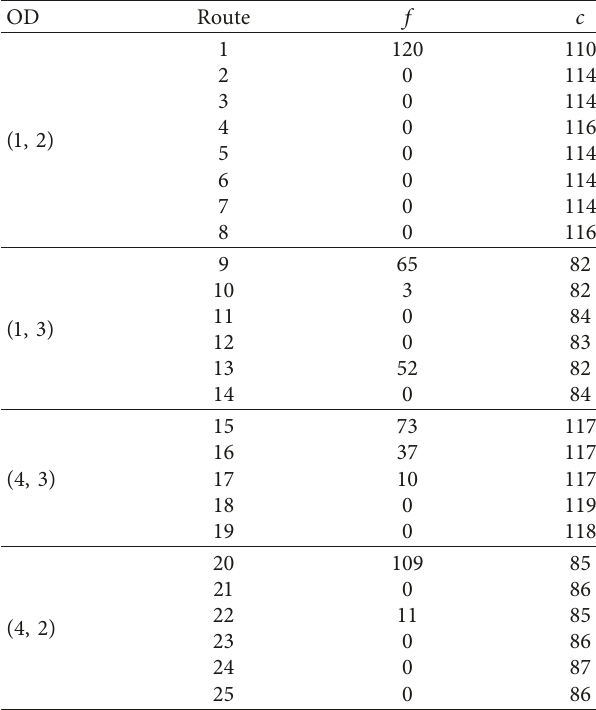
Table 9: OD-route-link incidence matrix. OD